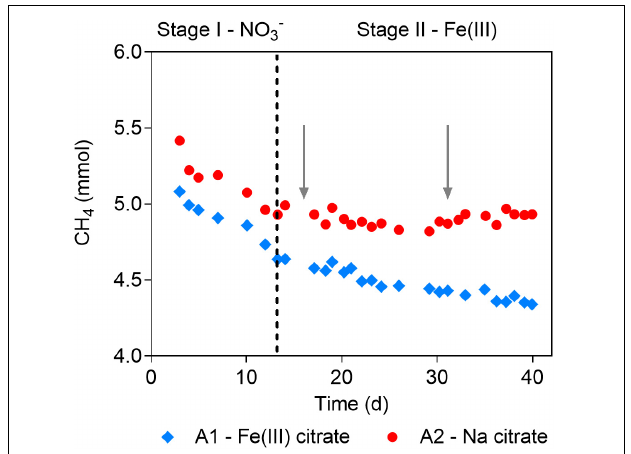
FIGURE 1 | Methane profiles before and after Fe(III) addition in the short-term batch tests. Stages are divided by dashed line. In Stage I, nitrate was the electron acceptor for anaerobic oxidation of methane (AOM) in both A1 and A2. In Stage II, Fe(III) citrate was added to A1 as the electron acceptor for AOM, and sodium citrate was added to A2. Gray arrows show the addition of Fe(III)- and sodium citrate to A1 and A2, respectively.